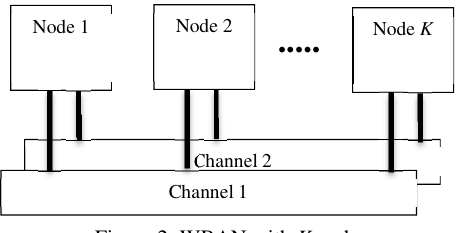
Figure 2: WBAN with K nodes